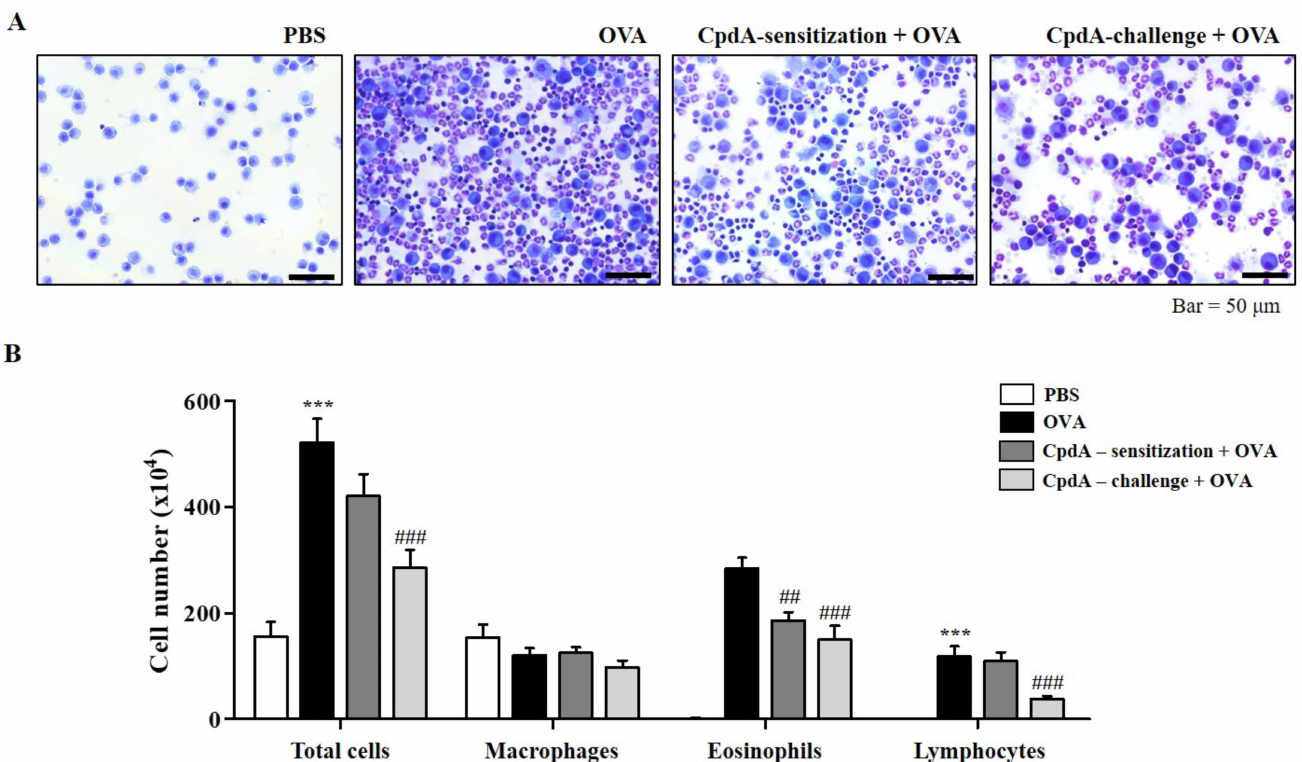
Figure 2. Compound A suppresses OVA-induced immune cell accumulation in BALF of FFA4- WT mice. ( A ) Mice were sensitized with OVA twice by i.p. injection on day 0 (D0) and D14, and later challenged on D28, D29, and D30 with nebulized OVA. Compound A was administrated intraperitoneally at the dose of 30 mg/kg, 30 min before OVA sensitization or before OVA challenge. BALF cells were stained using May-Grünwald stain and counted. ( B ) Total cell counts, eosinophils, macrophages, and lymphocytes in BALF. The results are presented as the mean ± SEM of cell count values ( n = 5). *** p < 0.001 vs. the PBS-treated group, ## p < 0.01, ### p < 0.001 vs. the OVA-treated